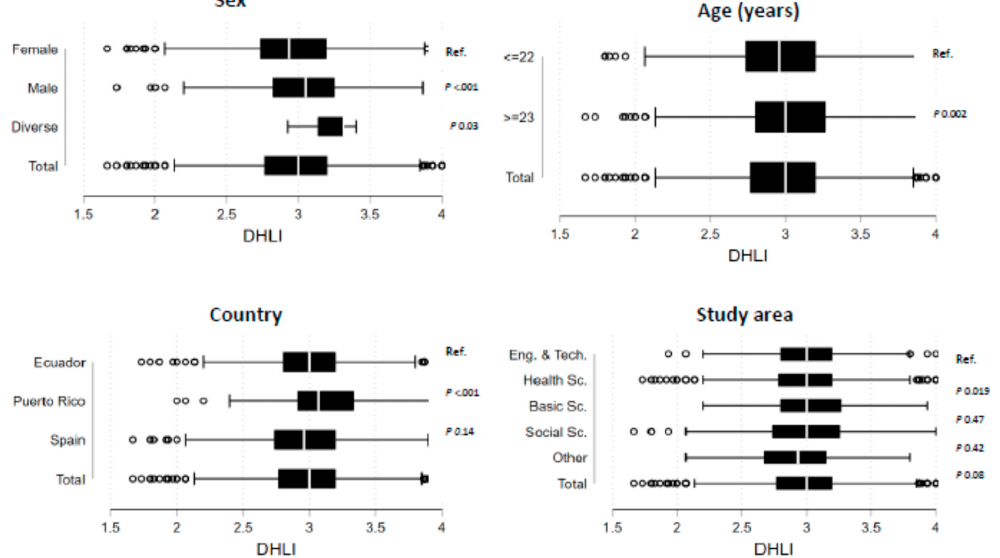
Figure 1. Digital health literacy scores according to the characteristics of the sample. Box plot corresponded to the score of digital literacy on COVID-19 according to the characteristics of sex, age, country of residence, study area (Eng. & Tech. = Engineering sciences and technologies; Health Sc. = Life sciences and health; Basic Sc. = Basic Science; Social Sc. = Social sciences and humanities), level of education, satisfaction with the information on COVID-19, and the presence of chronic disease in the student (No Cron. Cond = no chronic disease; Cron. Cond. = chronic disease). Next to each category were placed the p values obtained by the Kruskall–Wallis non-parametric test (Ref =